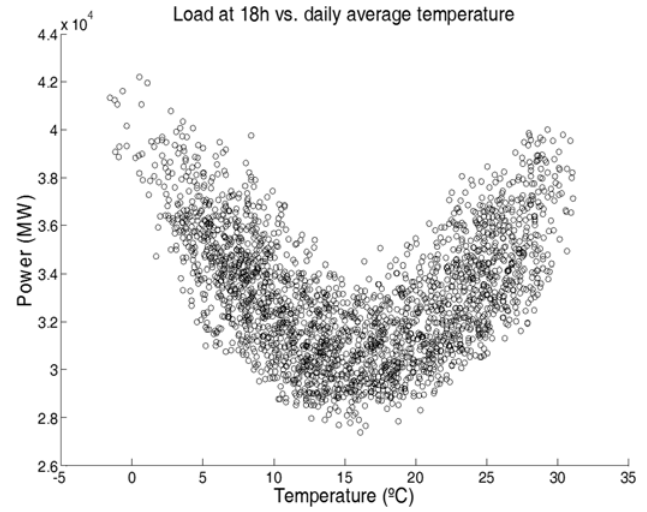
Figure 3. Scatter plot of national load at 18 h against the daily average temperature in Madrid.